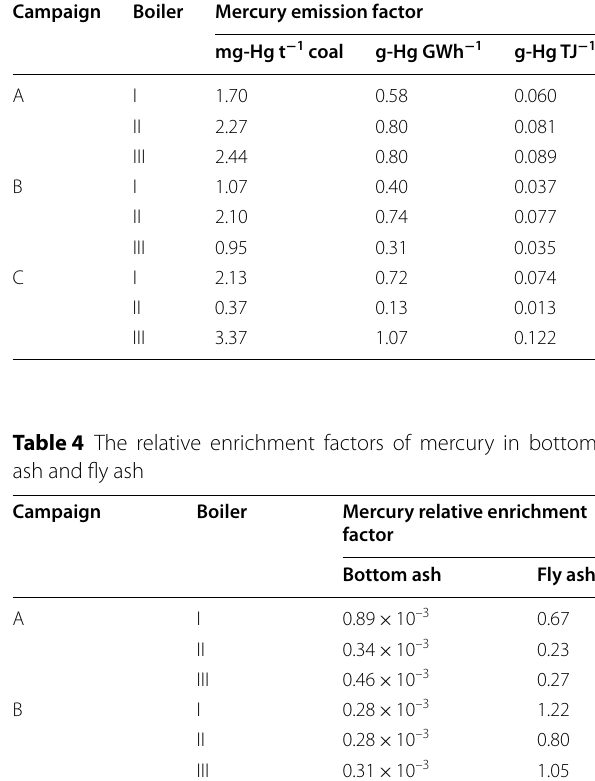
Table 3 The mercury emission factor for campaign A, B and C in the coal-fired power plant investigated Campaign